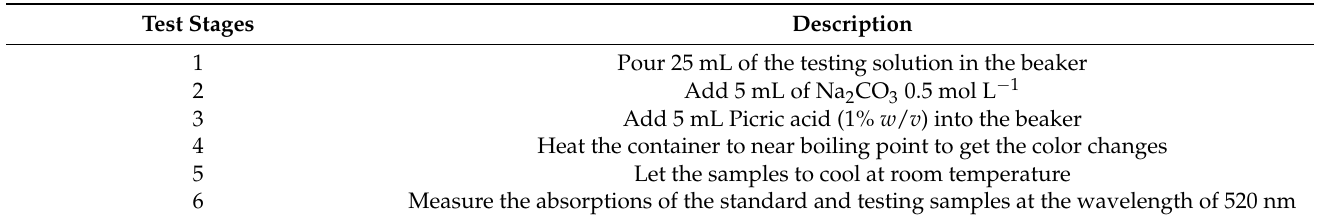
Table 1. Stages of cyanide detection experiment according to US Patent 4871681A [42]. Test